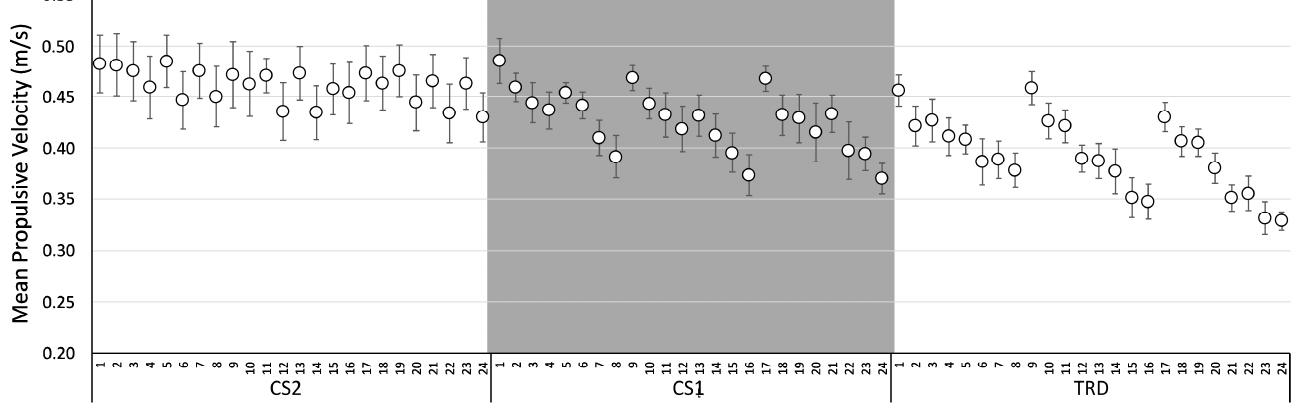
Figure 5. Mean Propulsive Power for Protocols CS2 (Cluster 2), CS1 (Cluster 1), and TRD (Traditional). Data are expressed as mean values and standard error. 3.3. Jump Variables No statistically significant differences were identified between protocols for vertical jump height [F(2:20) = 0.015, p = 0.985; η p2 : 0.002] nor Δ CMJ [F(2:20) = 1.671, p = 0.213, η p2 : 0.143]. However, there were differences between times for CMJ height [F(3:30) = 18.346, p < 0.001, η p2 : 0.647], with post-hoc identifying differences between times CMJPre × CMJ0’ ( p = 0.02), CMJPre × CMJ5’ ( p < 0.001), and CMJPre × CMJ10’ ( p < 0.001). No difference between times was identified for Δ CMJ [F(1.20:12.00) = 3.588; p = 0.077, η p2 : 0.264]. No Protocol × Time interaction occurred for any of the variables related to the vertical jump. The jump performance data are presented in Table 2. Table 2. Data (mean ± SD) comparison between protocols for all jump performance variables and their respective effect sizes. Protocols (Mean ± SD)